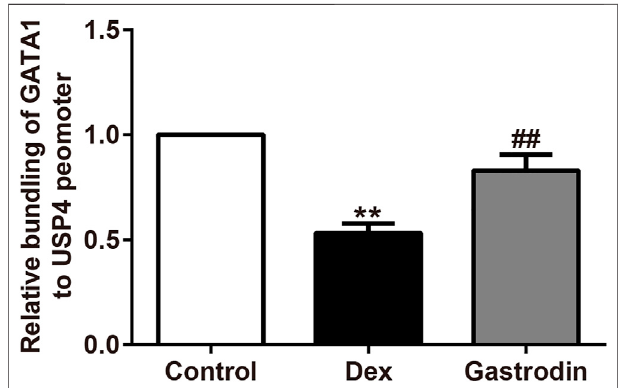
FIGURE 12 | Chromatin immunoprecipitation (ChIP) assay on the promoter of GATA1. The results were presented as mean ± SD ( n (cid:1) 3). ** p < 0.01, vs. Control, ## p < 0.01, vs. Dex. The concentration of gastrodin was 100 μ M.